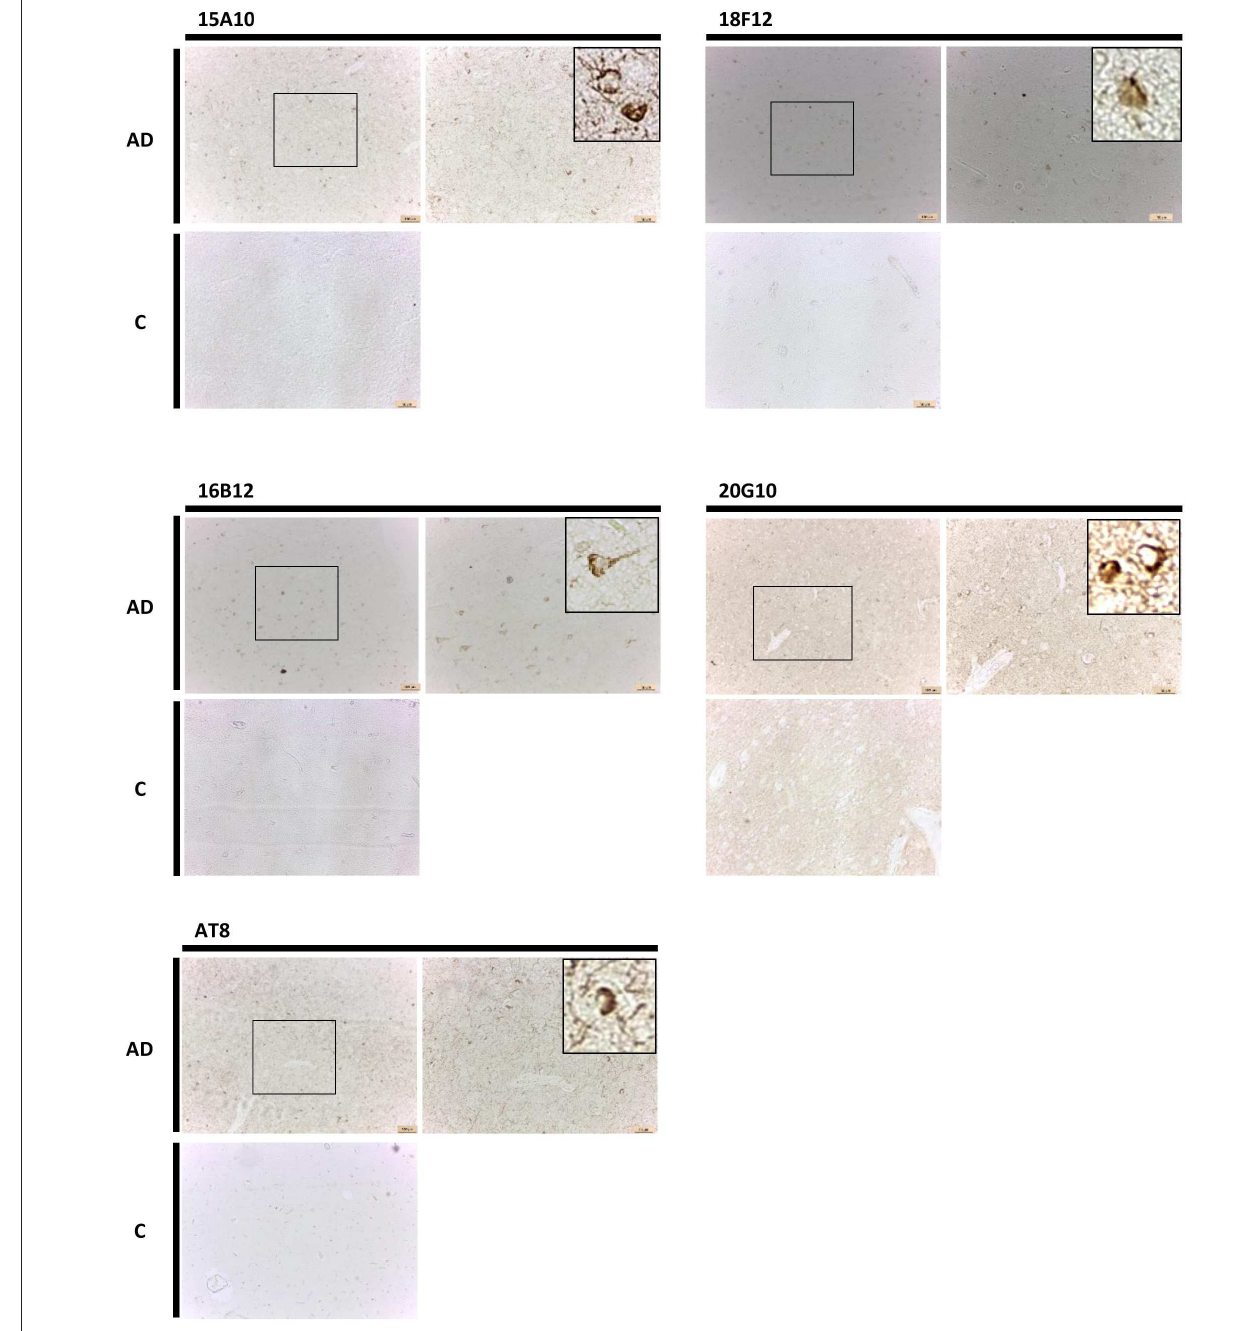
FIGURE 8 | Immunohistochemistry in human brain sections. Pictures represent immunohistochemical stainings performed using mAbs 15A10, 16B12, 18F12, and 20G10 on different regions of the cortex of human control subjects (C) and AD patients. Also shown is a magnification of the tangles detected.